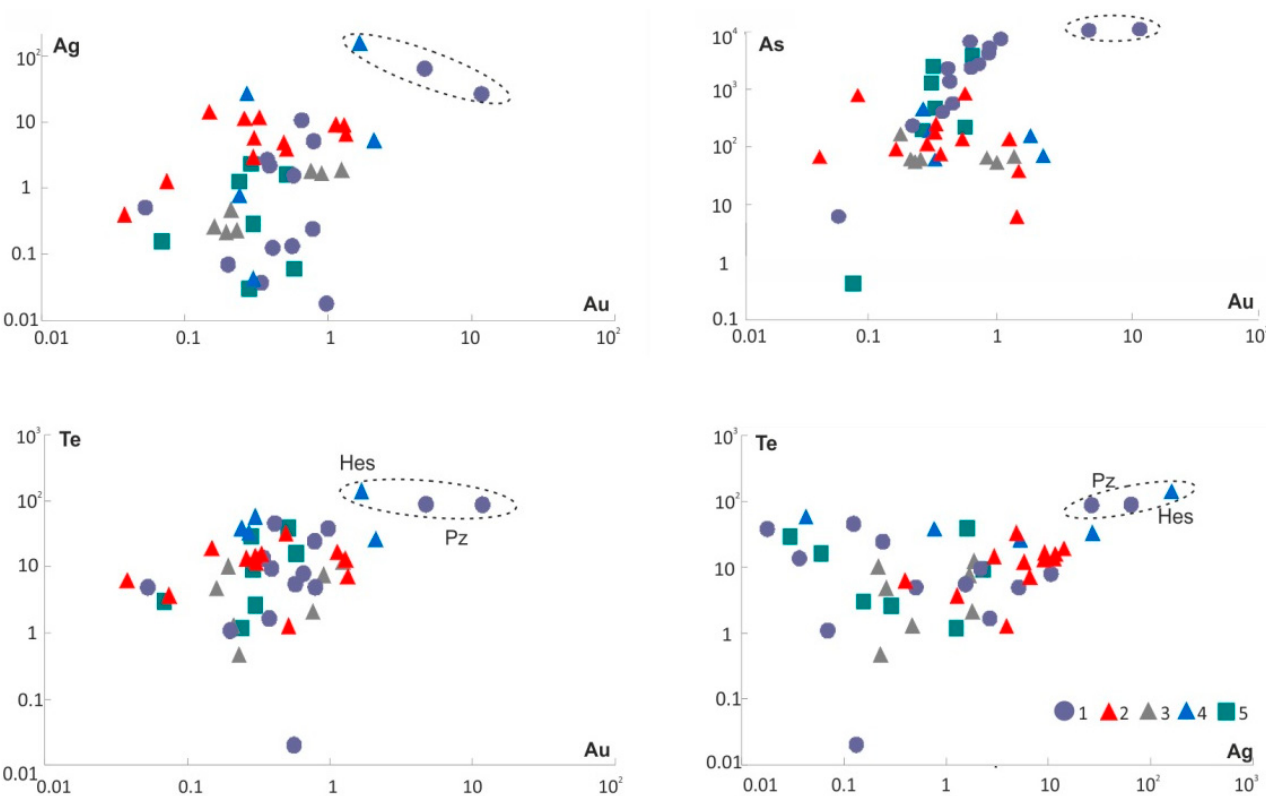
Figure 20. Binary diagrams of the contents of Au, Ag, Te and As (ppm) in pyrite of the Novogodnee-Monto Fe-Au-skarn deposit according to the LA-ICPMS data. Mineral assemblages in the ores: 1—magnetite-pyrite, 2—polymetallic, 3—gold-sulphide-magnetite in skarns, 4—gold-sulphide and gold-telluride, 5—quartz-carbonate. The dashed counter shows probable inclusions of petzite and hessite.